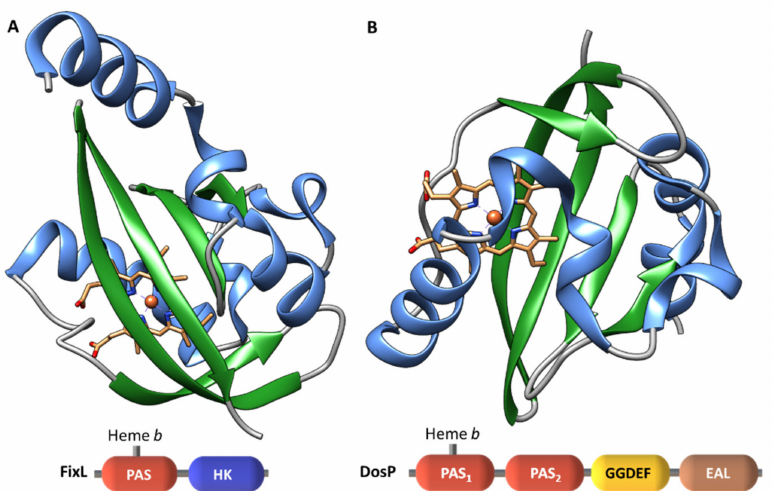
Figure 6. Structure of FixL ( A ) and DosP ( B ) PAS sensor domains. β -strands and α -helices are represented in green and blue, respectively. The hemes are colored by